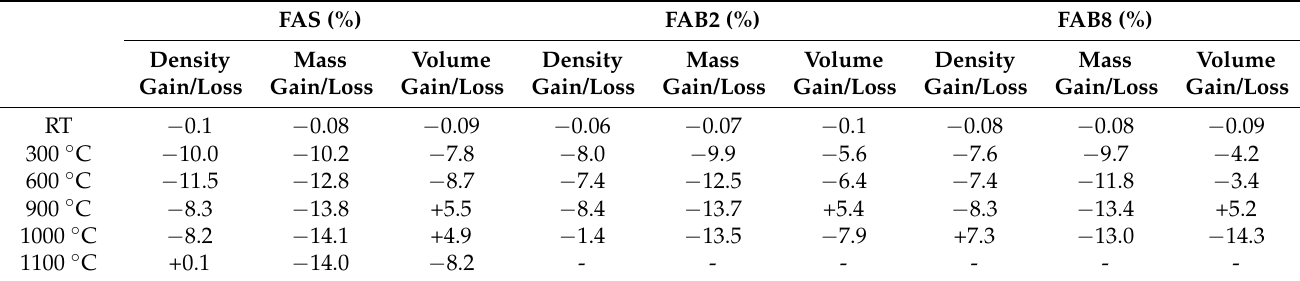
Table 2. Gain and loss of bulk density, mass, and volume of thin FAS and FAB geopolymers at elevated temperatures.